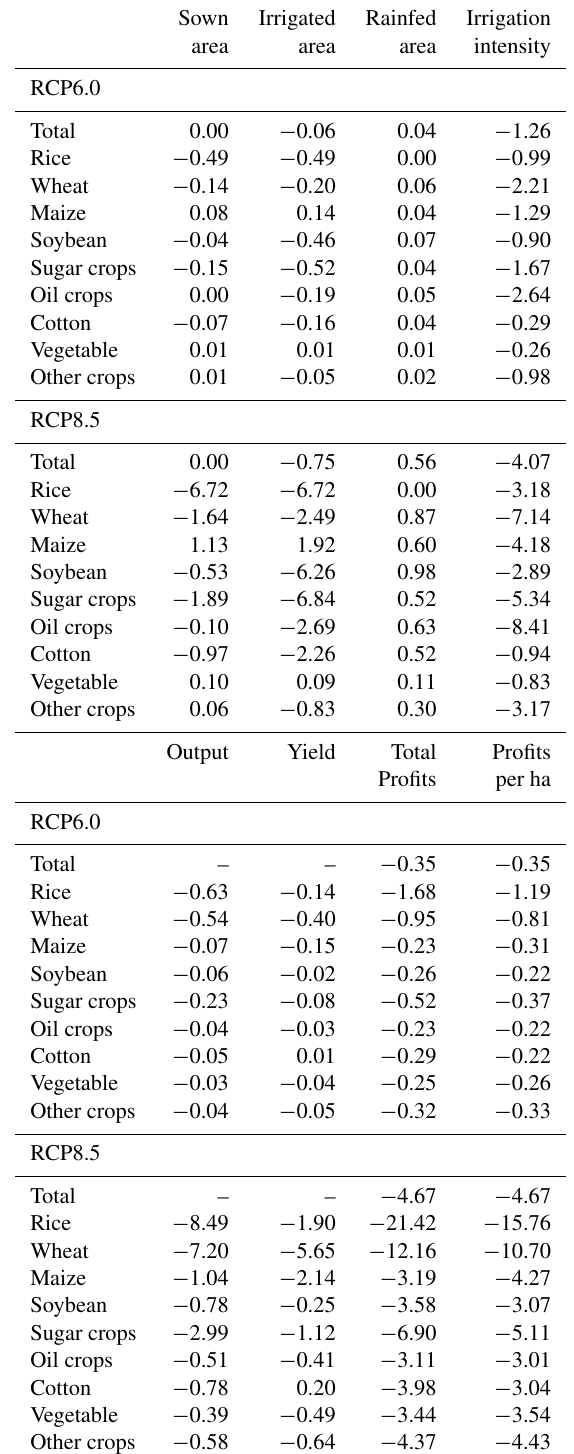
Table 6. Percent changes of key factors in the LRB under climate scenarios in 2030